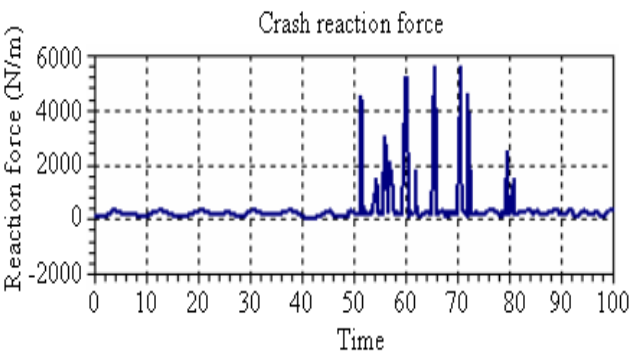
Figure 5. Vehicle crash reaction forces.